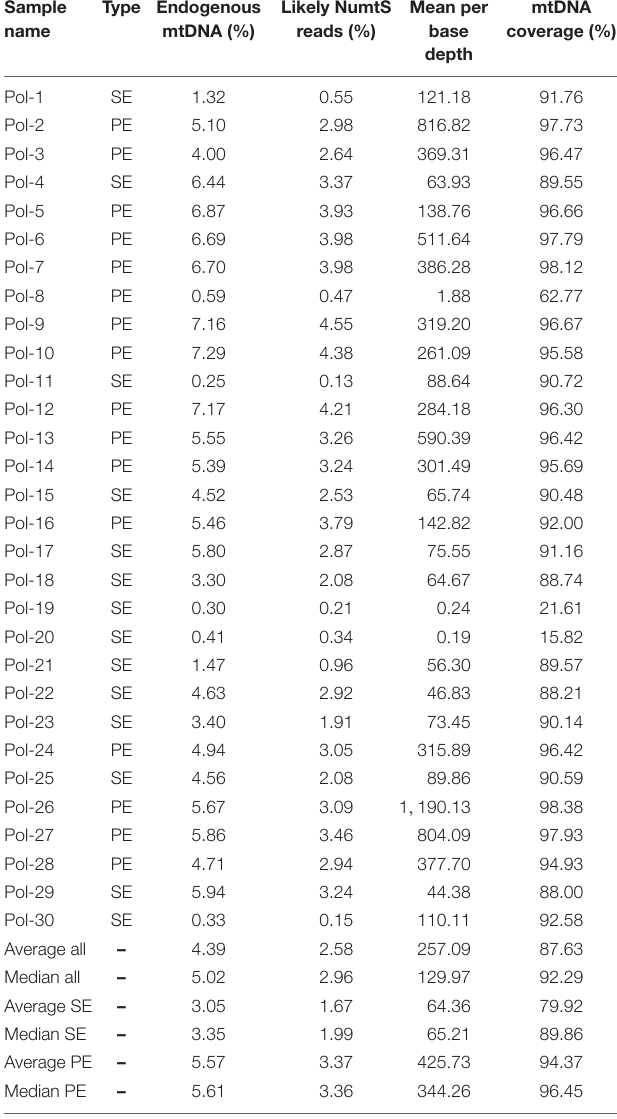
TABLE 2 | Sequencing information of Polizzello